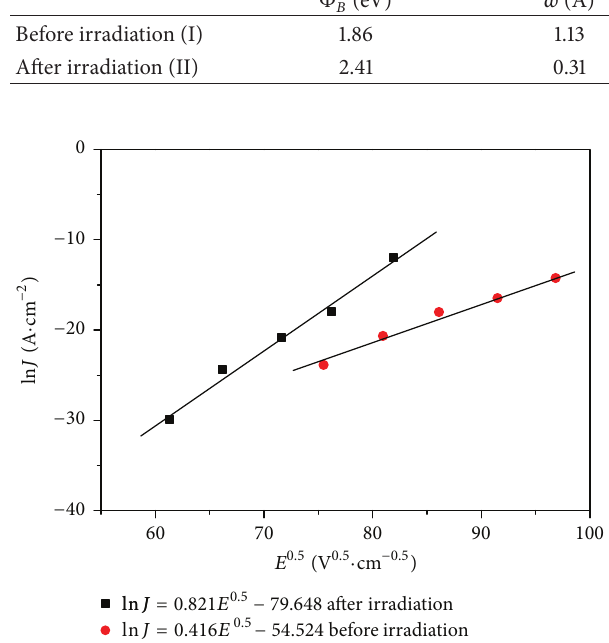
Figure 6: The relation patterns of ln 𝐽 - 𝐸 0.5 of the ZnO-based thin films before and after